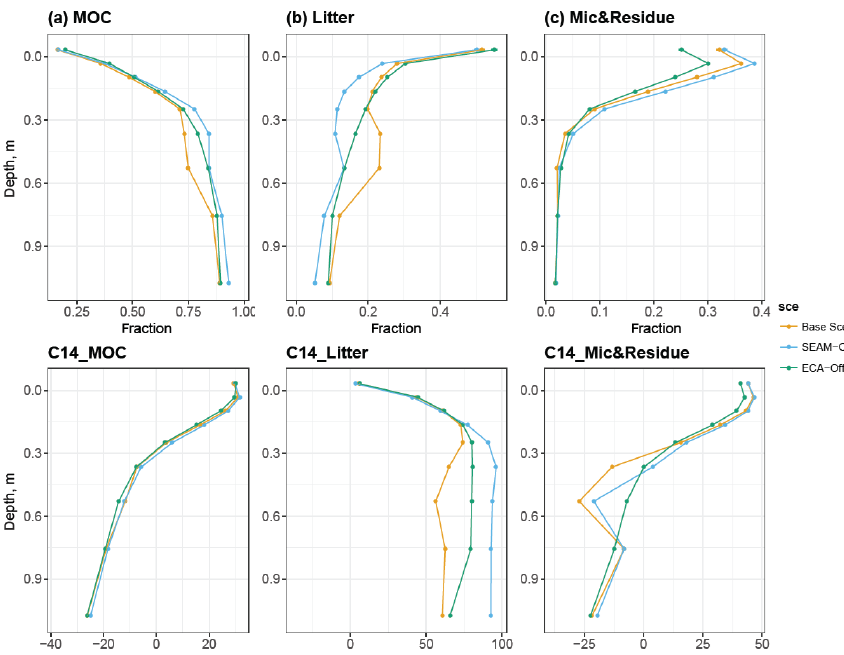
Figure 4. Simulated SOC fractions (upper panels) and their respective radiocarbon profiles (bottom panels) at 1m soil depth. Column (a) : mineral-associated C (MOC), including adsorbed DOM and adsorbed microbial residue; column (b) : litter, including woody, polymeric and soluble litter; column (c) : live and dead microbes. Data points are derived using data from the last 10 years of the model experiments. All model experiments used 200-year simulations and were not validated against the measured (cid:49) 14